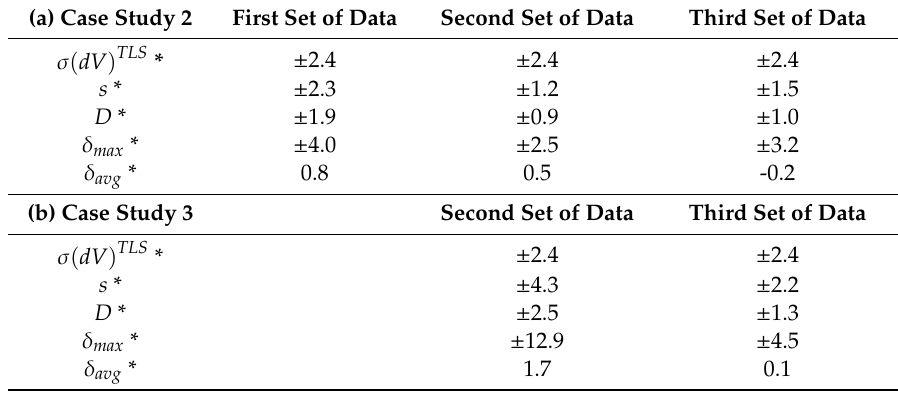
Table 11. Parameters of assessing the accuracy of the di ff erences in displacement values ( δ dV i ); ( a ) Case study 2; ( b ) Case study